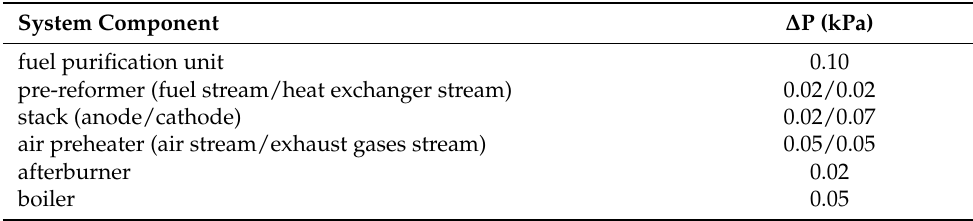
Table 1. Pressure drops in the biogas-SOFC process components